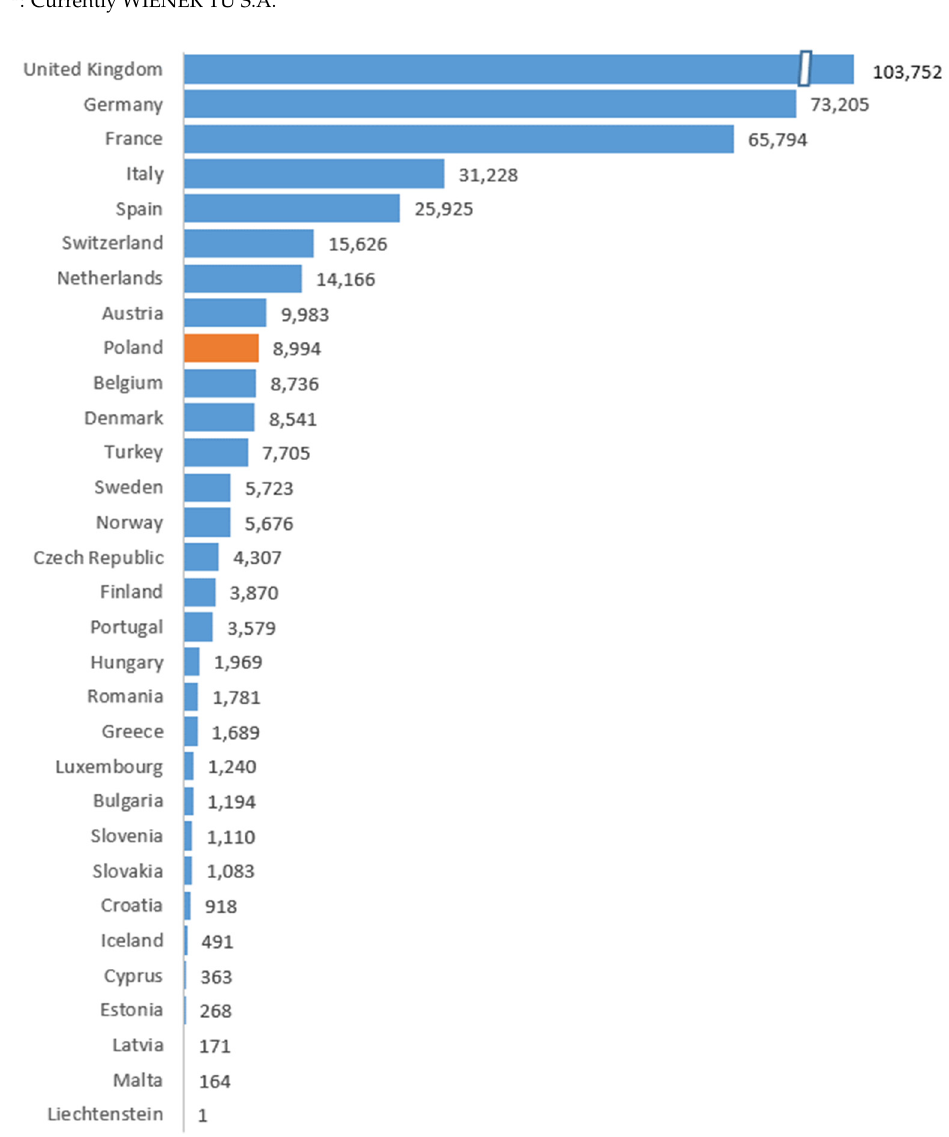
Figure 1. Gross direct P&C premiums written on domestic markets in 2019 (Insurance Europe 2021).